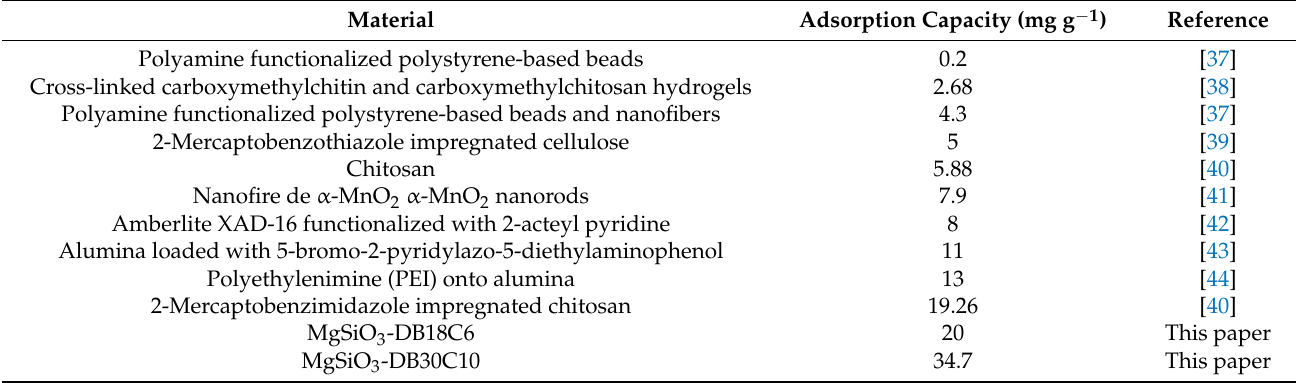
Table 7. Comparison of the materials in the study with the literature